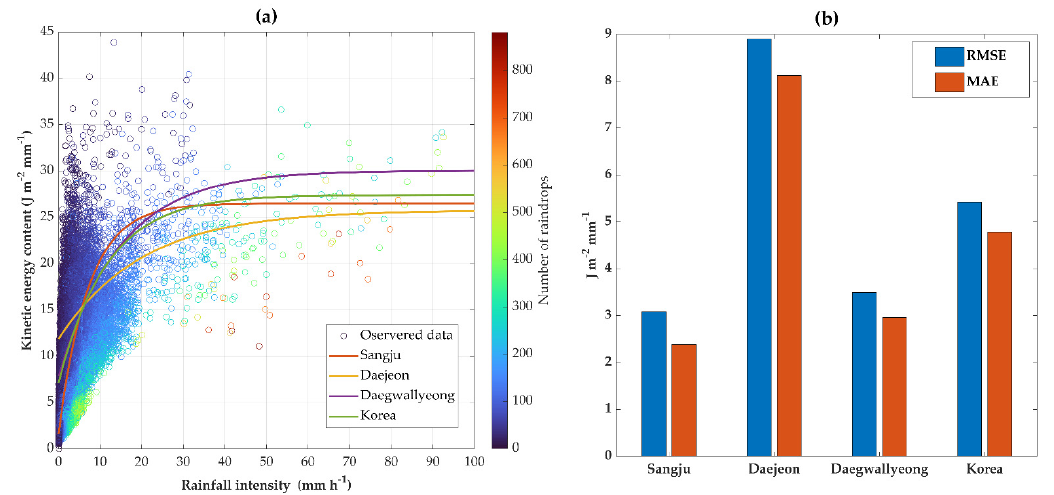
Figure 8. ( a ) Comparison and ( b ) statistical analysis results of 4 KE con –I r equations with measured data.